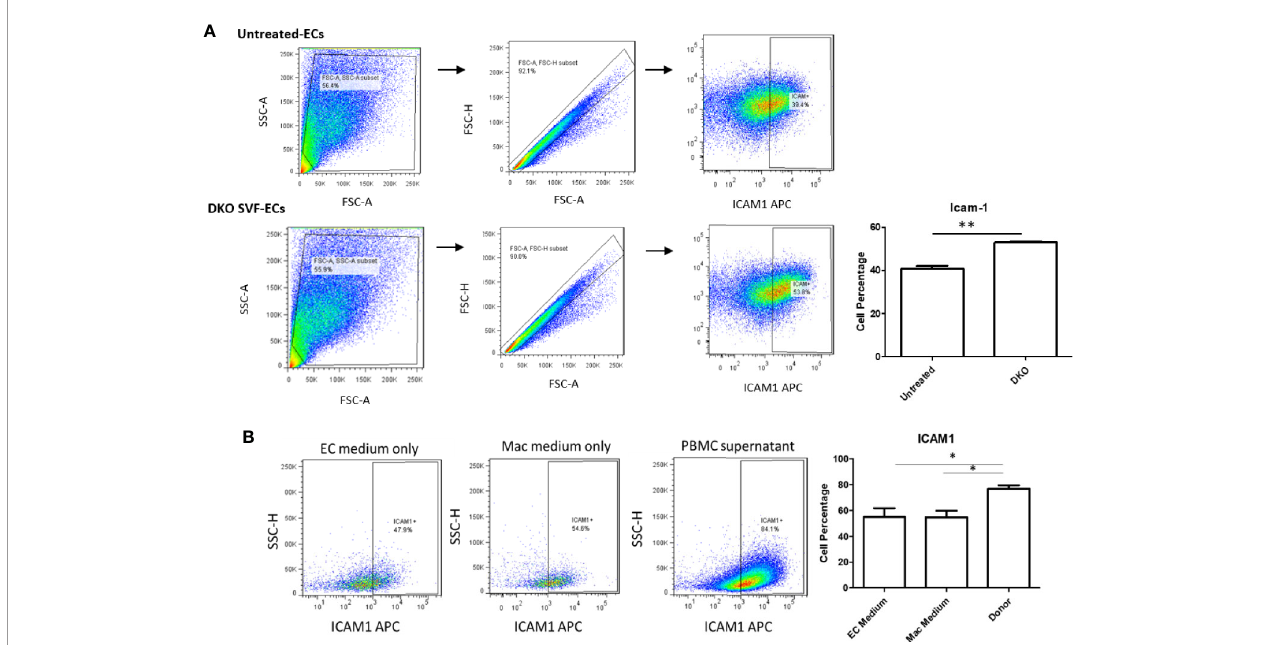
FIGURE 7 | DKO SVF and human macrophage-conditioned medium promote HAEC activation. (A) Stromal vascular fraction (SVF) from 20-week old DKO male mice on NC was cultured overnight in macrophage differentiation medium. Centrifuged supernatant was incubated with human aortic ECs (HAECs) for 24 hours. Untreated HAECs were incubated with EC medium; untreated (n=3), DKO-treated (n=3). (B) Isolated human peripheral blood mononuclear cells (PBMCs) were grown for 7 days in macrophage differentiation medium. Afterwards, cultured HAECs were incubated with centrifuged supernatant (macrophage-conditioned medium) for 24 hours. HAECs in EC medium group were incubated with EC medium only for 24 hours and HAECs in Mac medium group were incubated with macrophage medium only for 24 hours; EC medium (n=11), Mac medium (n=11), Cond Mac medium (n=12). * p <0.05; ** p